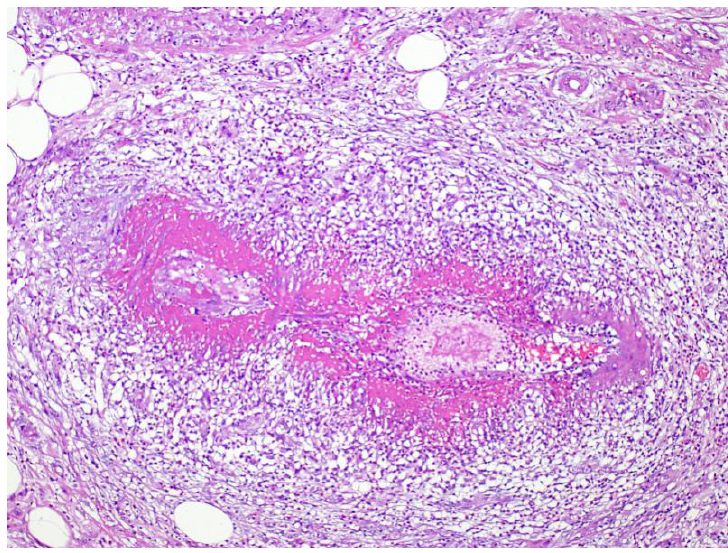
FIGURE 3. Histopathological image with hematoxylin and eosin stain of cross-sections of the spermatic cord reveals necrotizing vasculitis of the spermatic artery and veins (original magnification